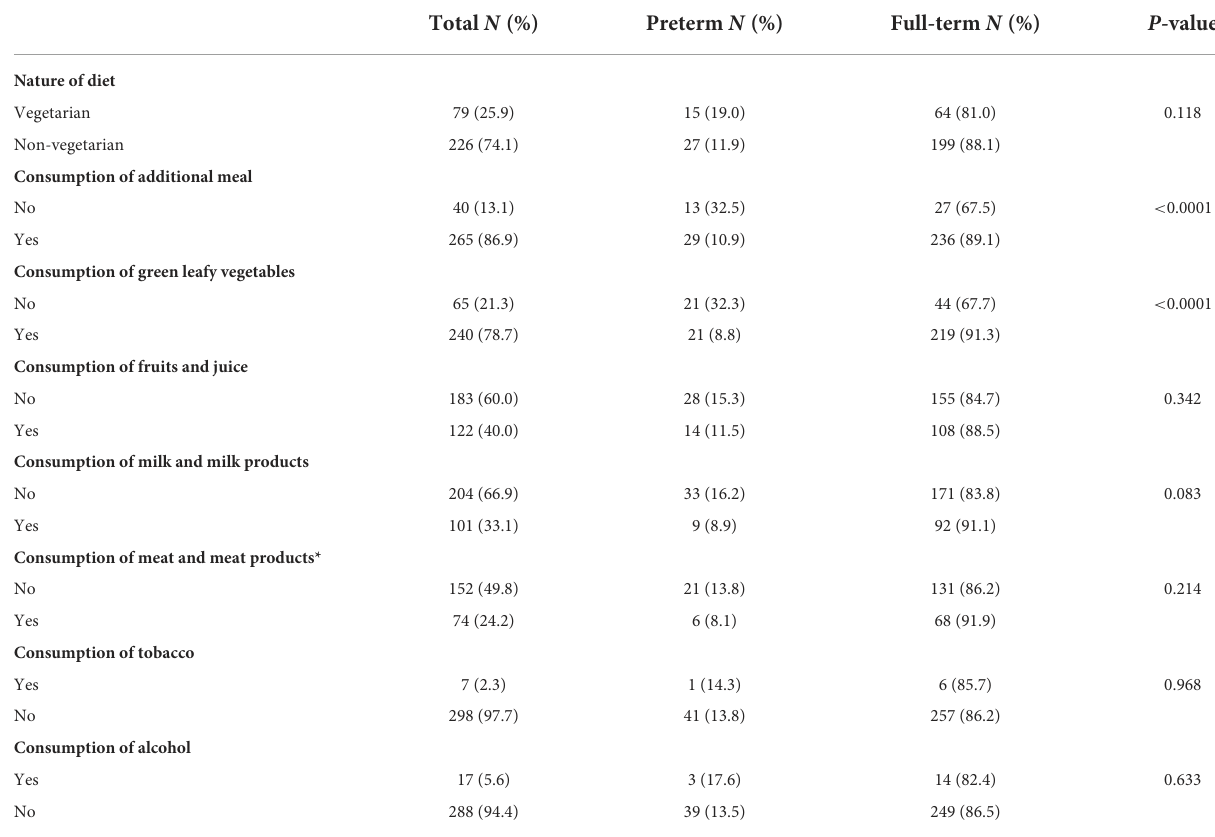
TABLE 2 Dietary behavior during pregnancy among study